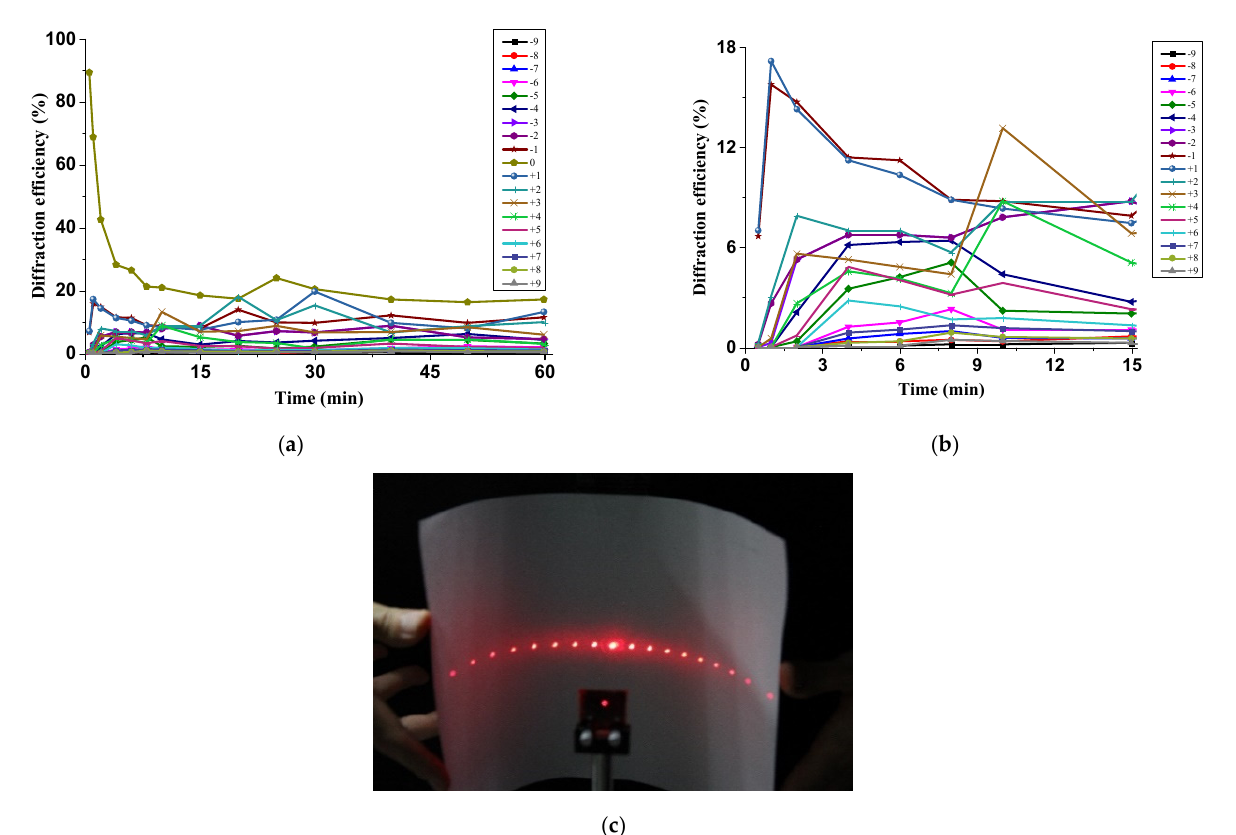
Figure 5. ( a ) Diffraction measurements for the surface relief grating at various recording time. ( b ) A close-up view for ( a ). ( c ) An appearance of diffractions from the reshaped surface relief grating.